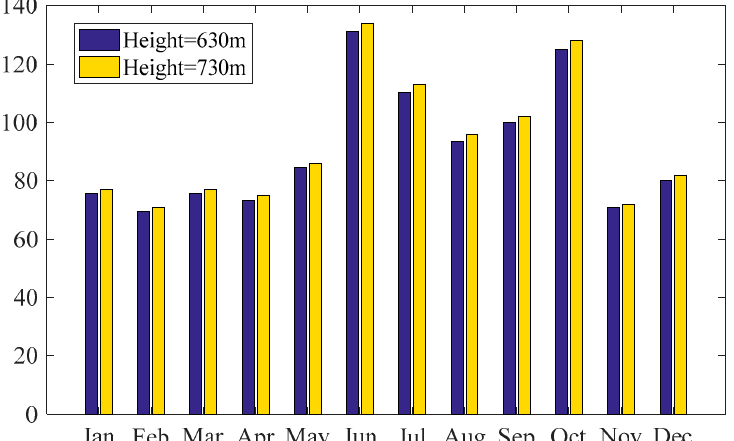
Figure 10. Monthly wind power (kWh/m 2 ) on 630 m and 730 m heights.